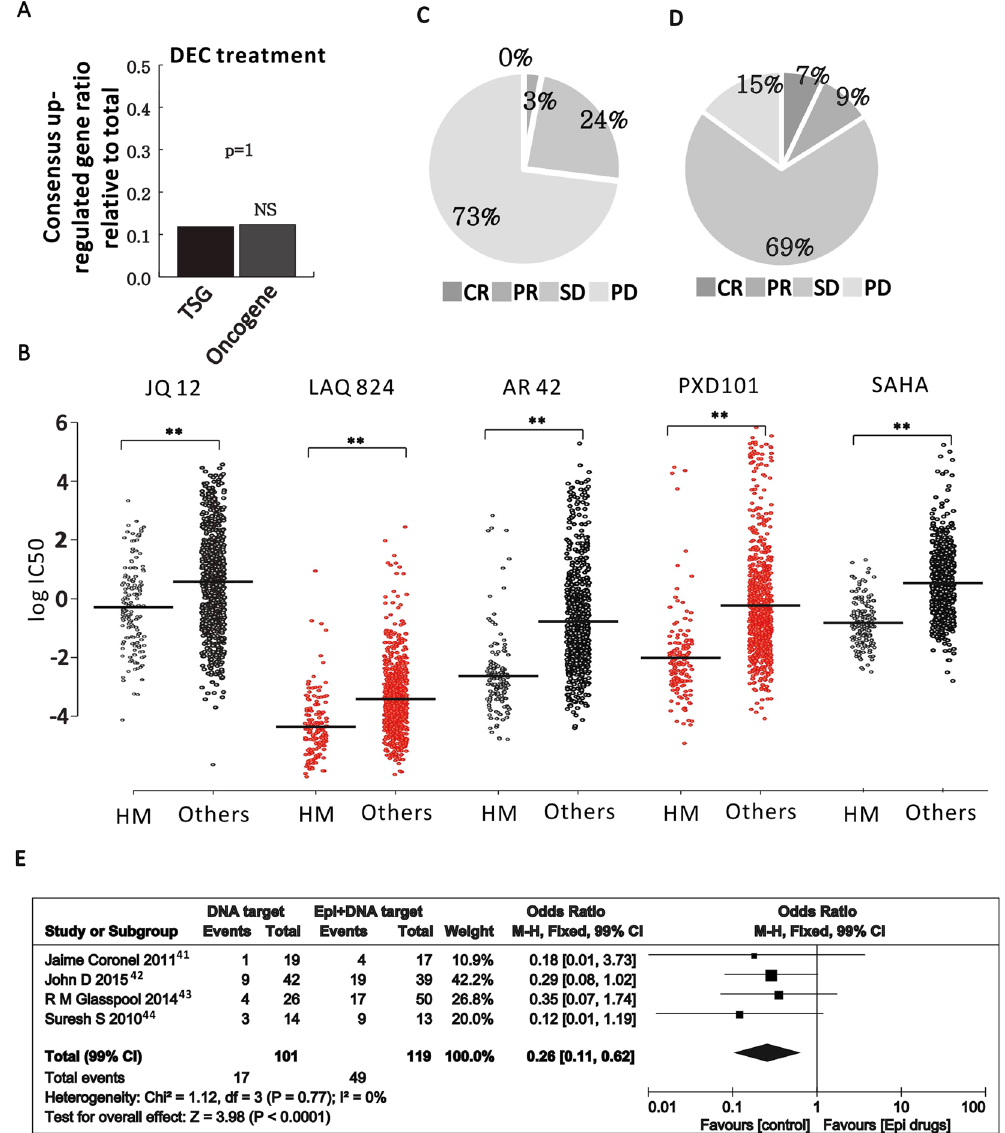
Figure 1. Epigenetic targeting drugs application in clinical. ( A ) Global gene expression from 18 primary AML samples in response to DEC treatment were collected (GSE40442) and the portion of consensus upregulated TSGs or Oncogenes, relative to total TSGs or oncogenes are plotted. P value is based on Chi-square test. ( B ) IC 50 of hematopoietic (HM) versus other cell lines to HDAC inhibitors. Each dot represents the IC 50 of one cell line to one drug as labeled on the top. The left group is the HM cell lines and the right group is the collection of all the other cell lines except HM cell lines. ( C ) The response rate of ETD alone applied to 1110 patients with solid tumors. CR, complete response; PR, partial response; SD, stable disease; PD, progressive disease. Response identification based on Response Evaluation Criteria in Solid Tumors (RECIST). ( D ) The response rate of classic chemical drugs applied to solid tumors according to TCGA. ( E ) Forest plot of objective response rate (ORR) related to DTD combined with ETD. The overall effect was statistically significant (P < 0.0001). Vertical line, “no-difference” point between two regimens; Horizontal line, 99% CI; Square, mean difference; Diamond, pooled mean difference for all studies. M-H fixed = Mantel-Haenszel fixed model. An odds ratio less than 1 means that combined therapy has successfully inhibited tumor